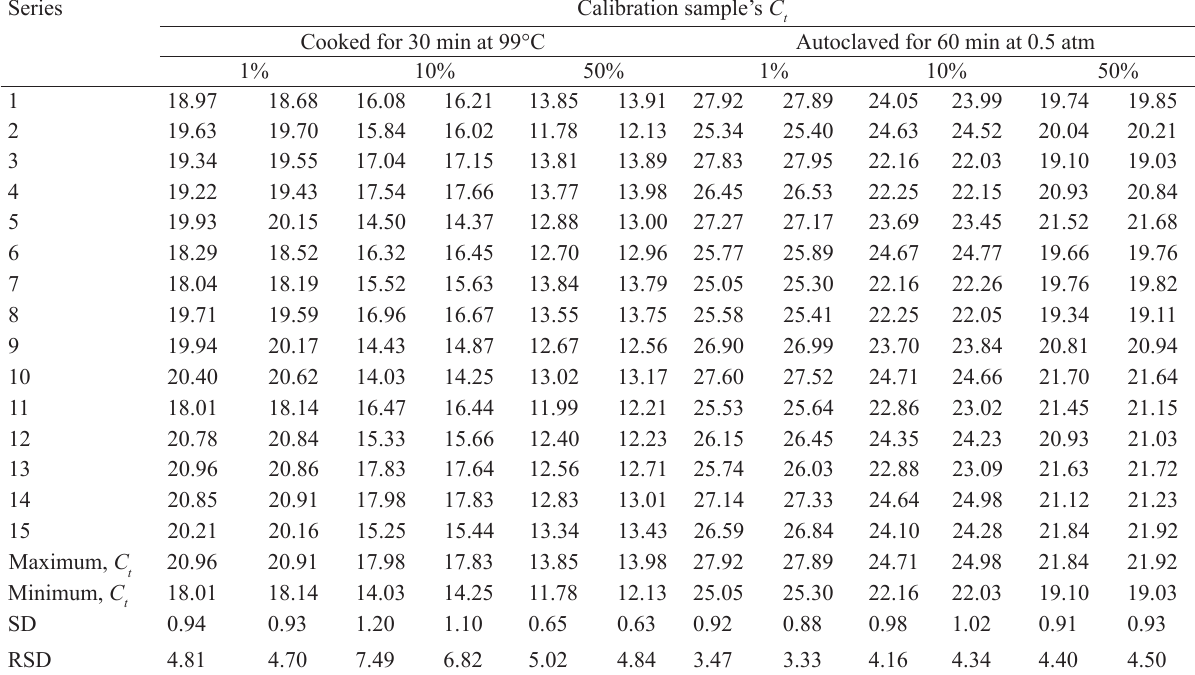
ranges for calibration samples t